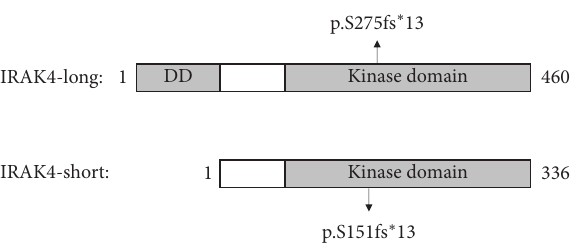
Figure 1: Schematic representation of two protein isoforms of IRAK-4 with the reported protein changes. The IRAK-4 protein contains an N -terminal death domain (DD), a hinge domain (labelled in white), and the kinase domain. The full-length DNA of the IRAK4 gene encodes the IRAK4-long protein consisting of 460 amino acids, while the alternative spliced gene encodes the IRAK4-short protein of 336 amino acids.